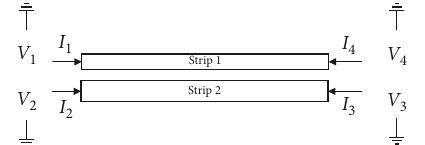
Figure 3: Structure of asymmetric directional coupler.